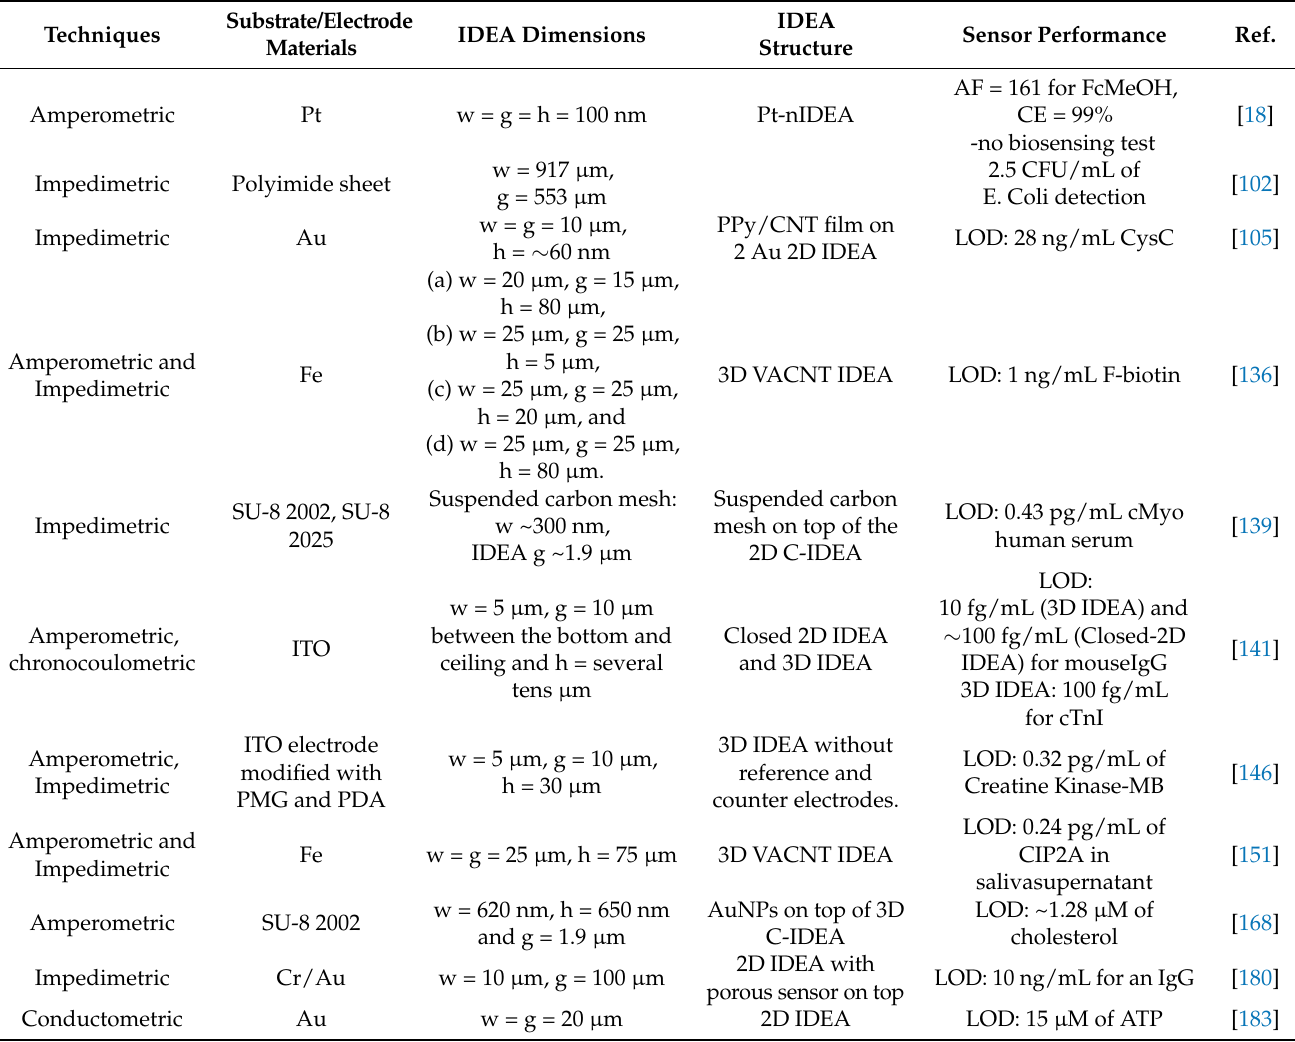
Table 3. IDEA based-electrochemical sensor in biomedical applications using amperometric and impedimetric detections.